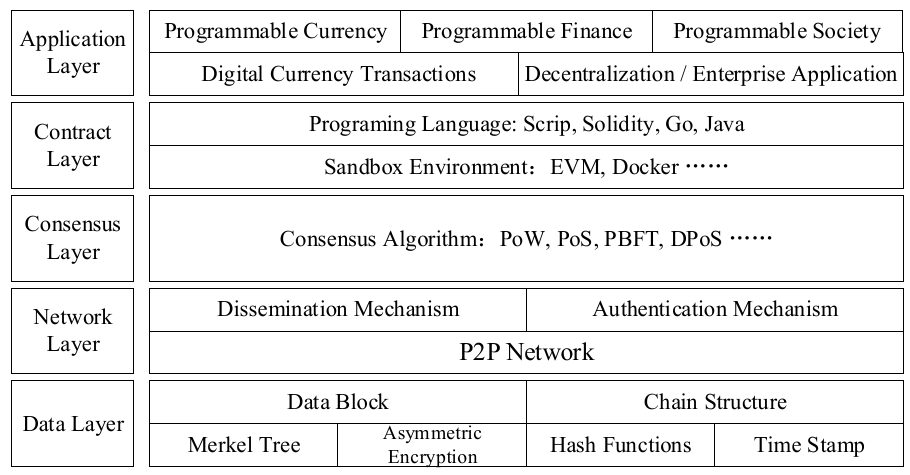
Figure 1. Blockchain platform